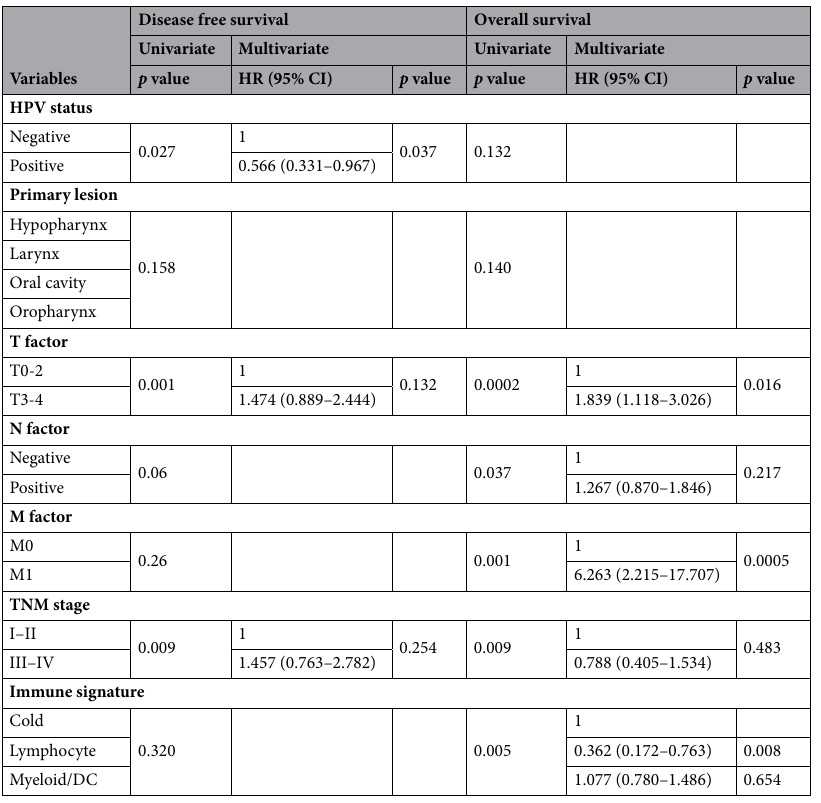
Table 2. Univariate and multivariate survival analyses of OS and DFS in HNSCC patients. DFS Disease free survival, OS Overall survival, HNSCC Head and neck squamous cell carcinoma, HR Hazard ratio, CI Confidence interval, DC Dendritic